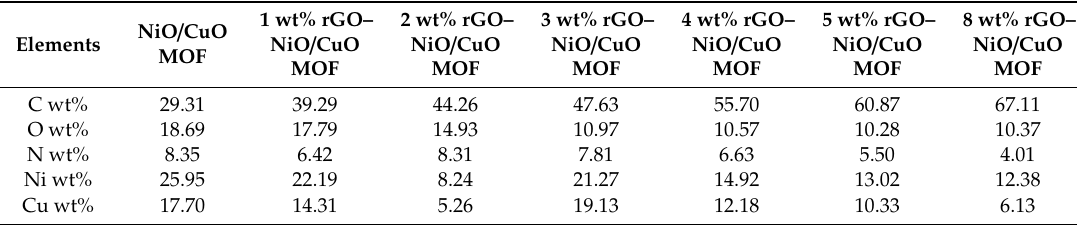
Figure 4. ( a ) NiO / CuO MOF, ( b ) 1 wt% rGO–NiO / CuO MOF, ( c ) 2 wt% rGO–NiO / CuO MOF, ( d ) 3 wt% Figure 4. ( a ) NiO/CuO MOF, ( b ) 1 wt% rGO–NiO/CuO MOF, ( c ) 2 wt% rGO–NiO/CuO MOF, ( d ) 3 Table 1. EDX: Elemental composition of NiO / CuO MOF, 1 wt% rGO–NiO / CuO MOF, 2 wt% rGO–NiO / CuO MOF, 3 wt% rGO–NiO / CuO MOF, 4 wt% rGO–NiO / CuO MOF, 5 wt% rGO–NiO / CuO Table 1 . EDX: Elemental composition of NiO/CuO MOF, 1 wt% rGO–NiO/CuO MOF, 2 MOF and 8 wt% rGO–NiO / CuO